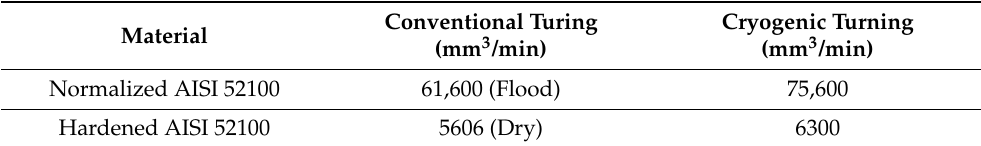
Table 9. Optimum productivity comparison through MRR, reprinted with permission from ref. [94].